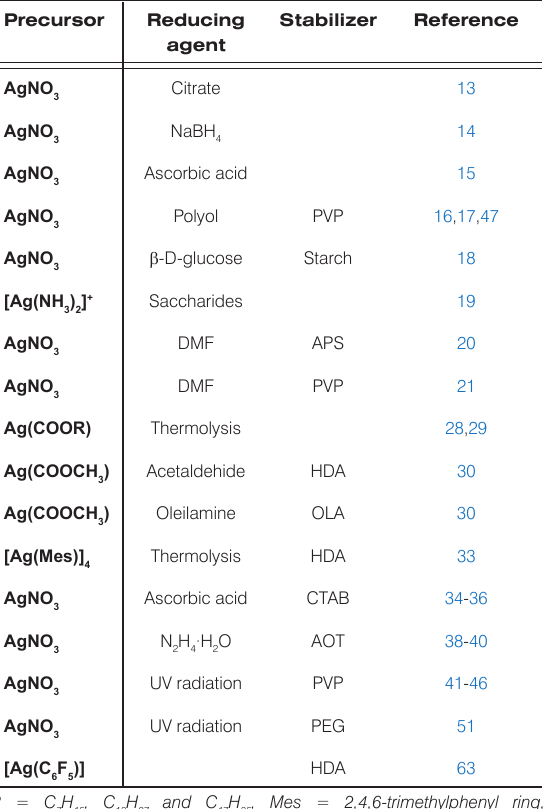
Table 1. Summary of some synthetic chemical methods for Ag NPs synthesis